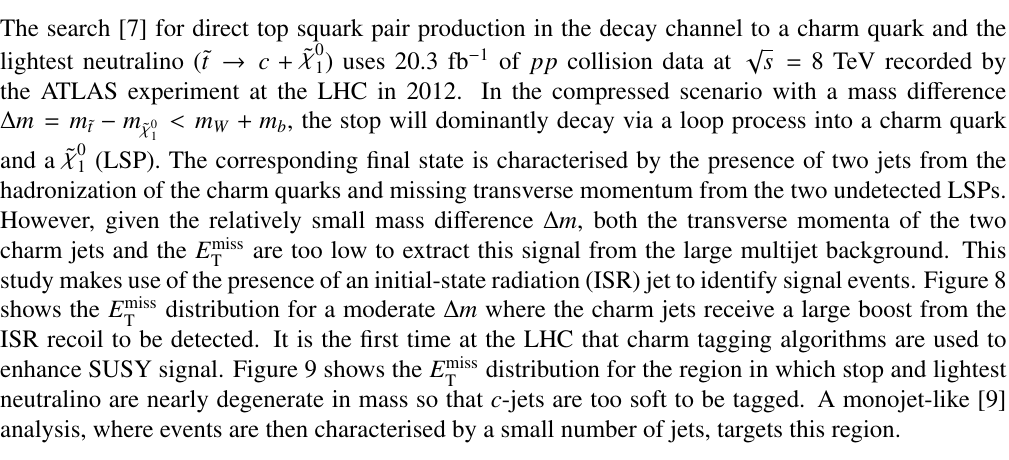
Figure 9: Measured E miss monojet selection compared to the SM predic- tions.